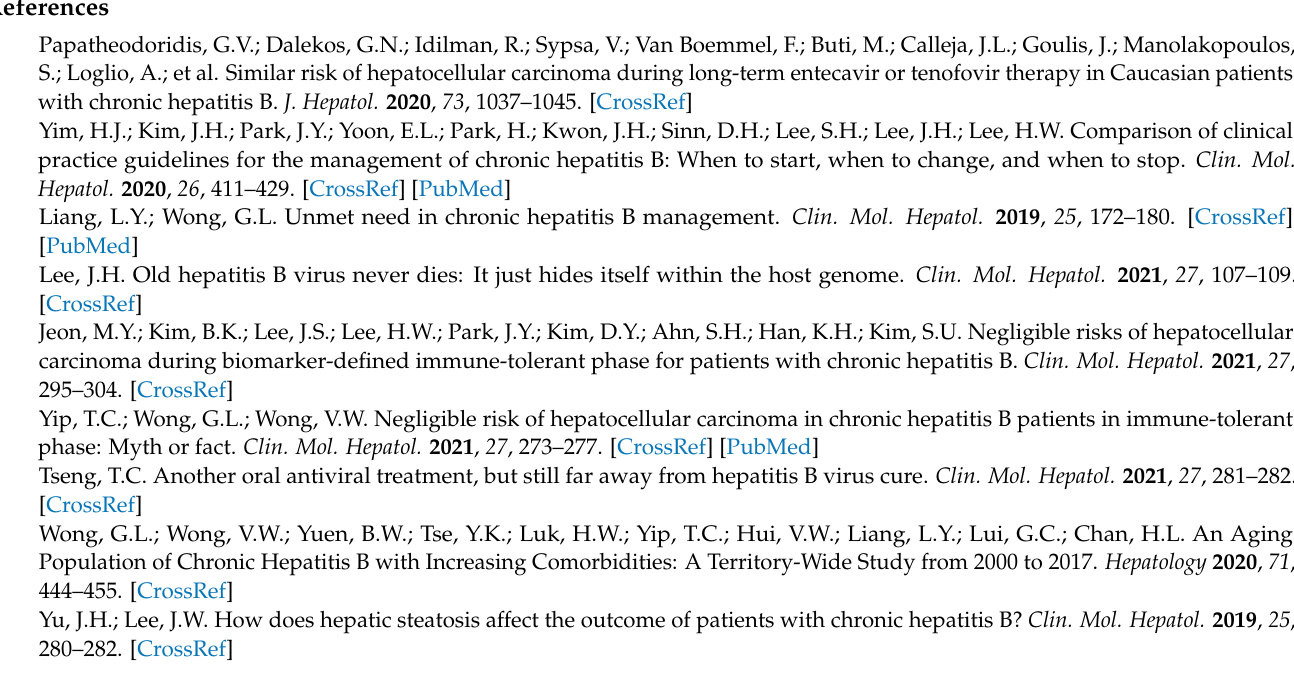
Figure S2: Comparison of physical activity between male and female. Table S1: Definition of diagnosis. Table S2: Multivariable analysis for HCC development in total study